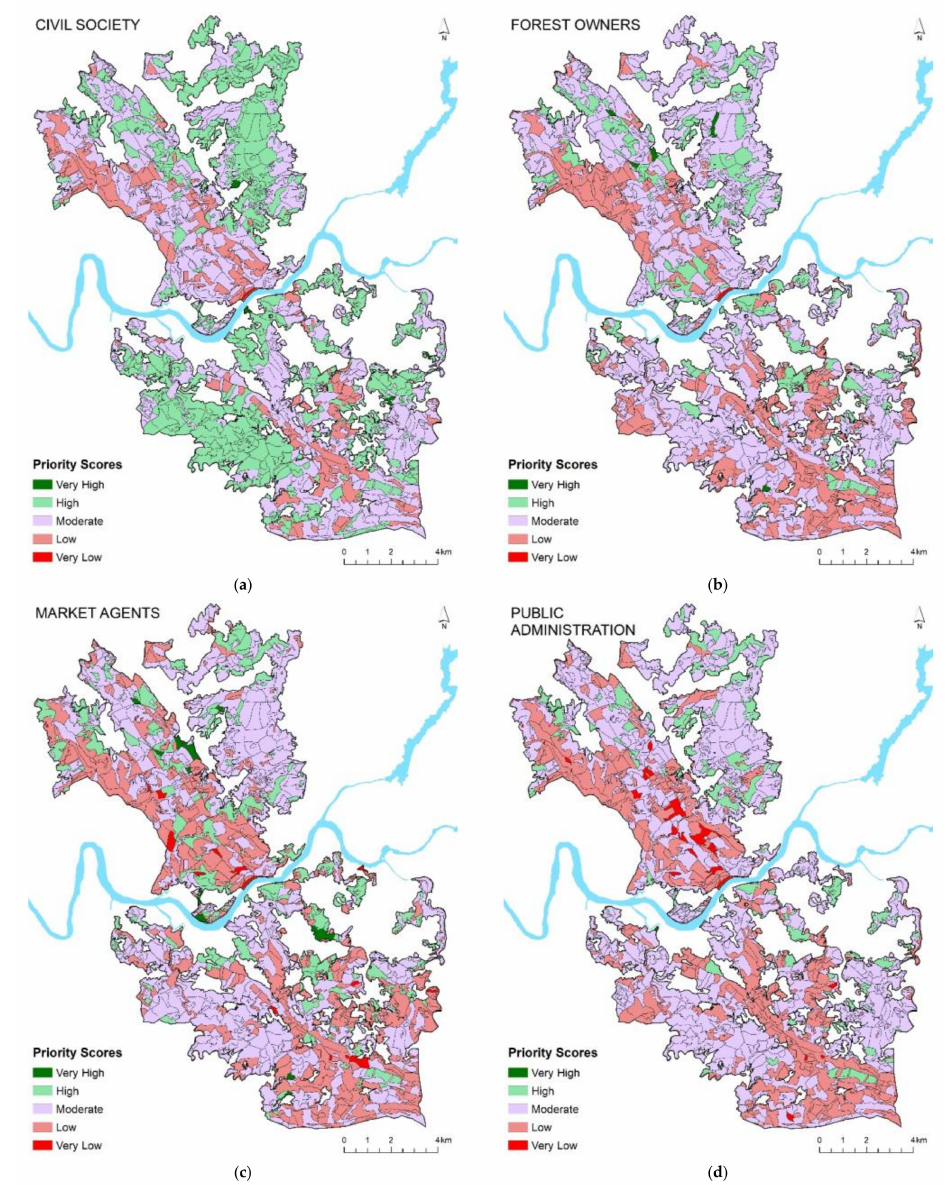
Figure 7. Priority scores of the allocation of the ecosystem services to the management units by interest group: ( a ) civil society; ( b ) forest owners; ( c ) market agents; ( d ) public administration. The priority scores were classified into five classes: very low ≤ 0.25; low ]0.25–0.40]; moderate ]0.40–0.55]; high ]0.55–0.70]; very high >